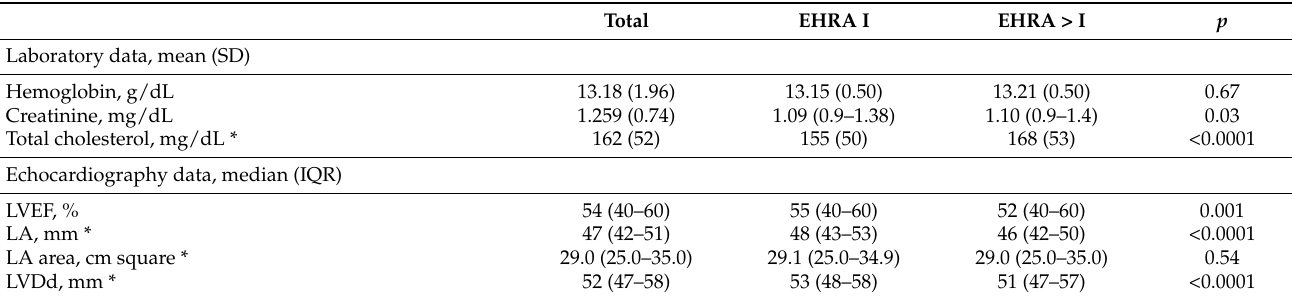
Table 3. Laboratory and echocardiography